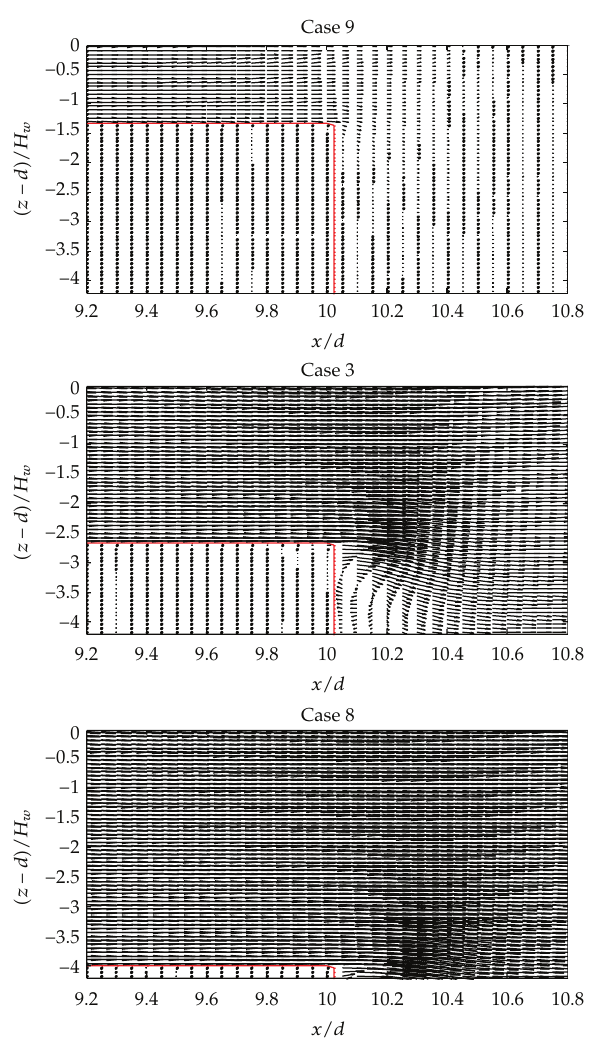
Figure 9: Velocity field at t (cid:2) g/d (cid:3) 0 . 5 (cid:7) 59 . 5 as a solitary wave passes over a submerged breakwater with di ff erent height h (cid:7) 4 . 0m (cid:2) Case 9 (cid:3) , h (cid:7) 3 . 0m (cid:2) Cases 3 (cid:3) , and h (cid:7) 2 . 0m and (cid:2) Case 8 (cid:3)